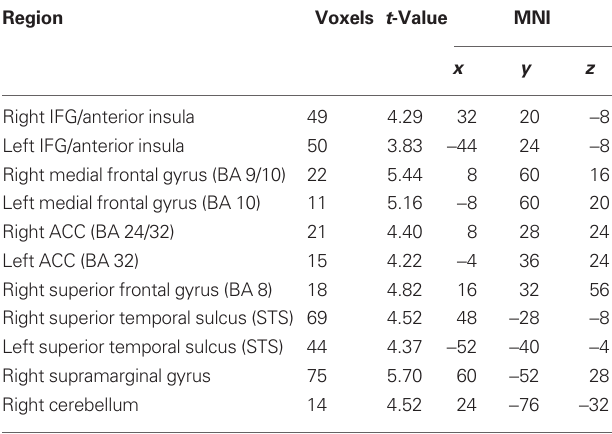
Table 3 | Within group main effects of unfairness for human conditions [controls unfair > controls fair].